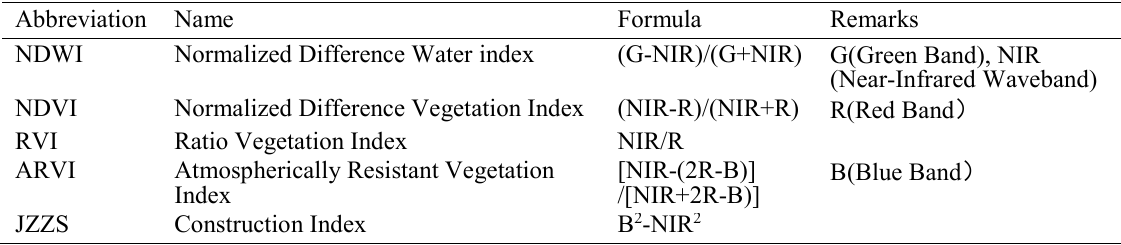
Table 1 Band computational formulas of decision statistics.